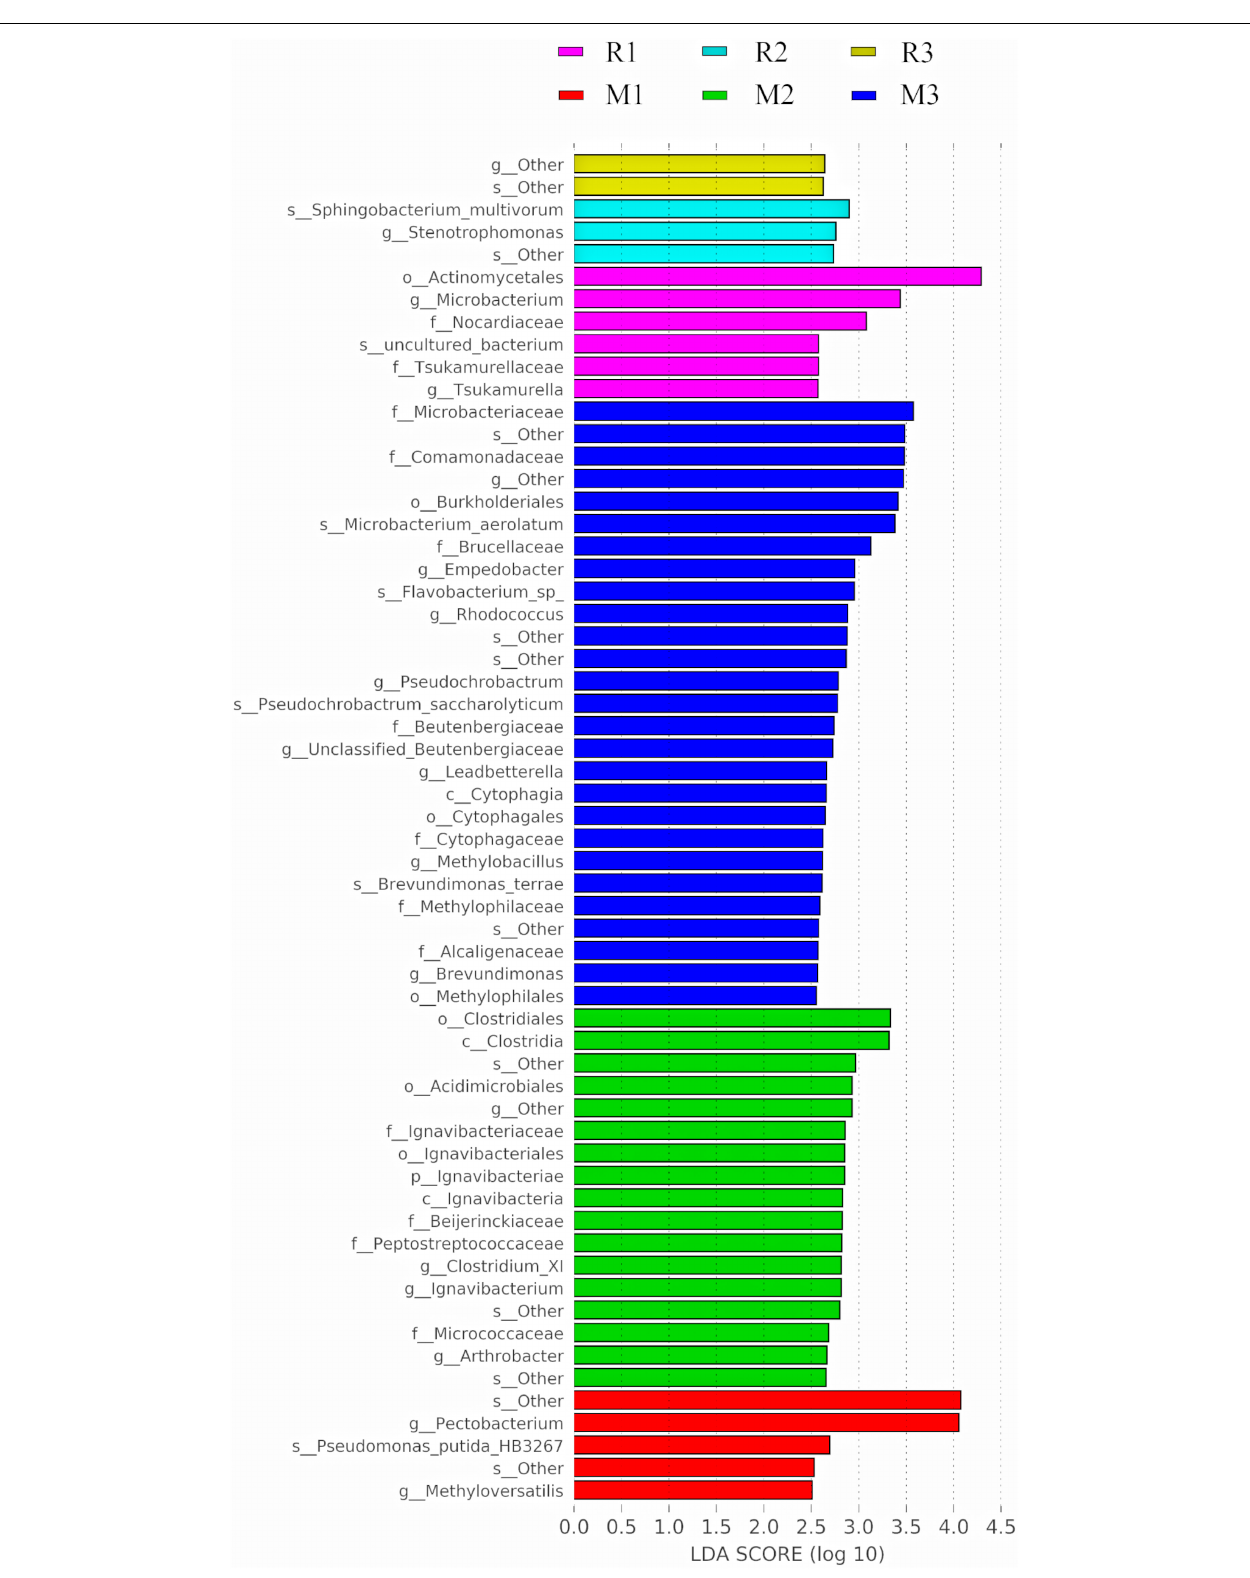
Frontiers in Microbiology |